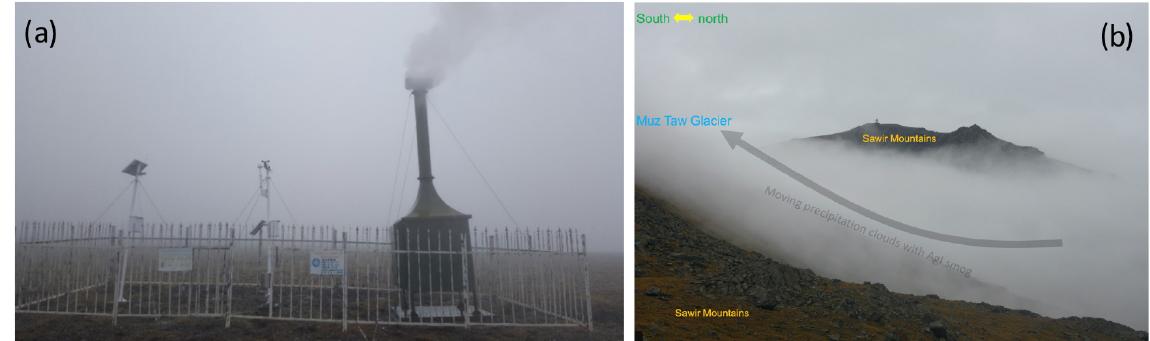
Figure 3. (a) Igniting the AgI smog generators along the terminal river when the clouds accumulated late in the afternoon of 19 and 22 August 2018. (b) The accumulation of clouds in the valley of the Muz Taw Glacier, favoured by the AgI particles, moved up towards the summit of the